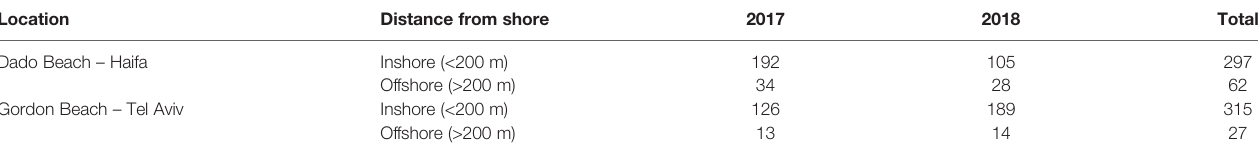
TABLE 1 | Number of inshore and offshore observations of R. nomadica in 2017 and 2018 in weeks 18-40 (May to September) in Haifa and Tel Aviv beaches. Location Distance from